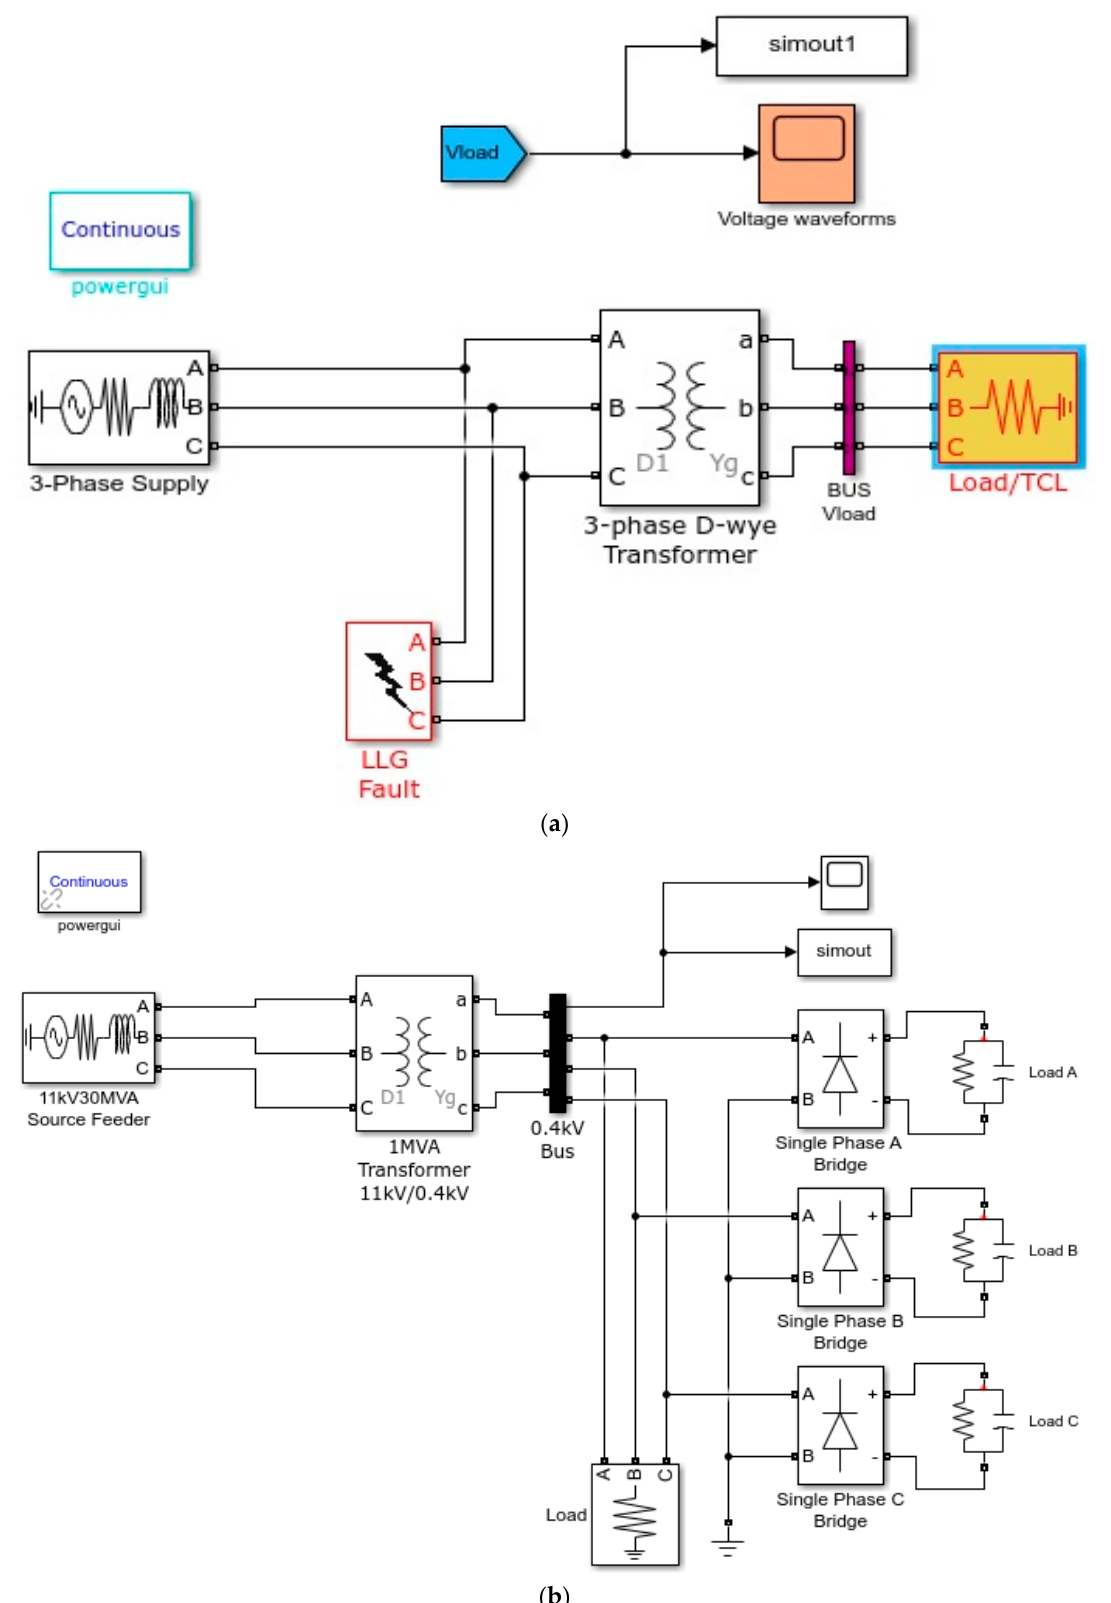
Figure 7. ( a ) Implemented network model with line faults using Simulink ® , ( b ) Nonlinear load model using Simulink ® .